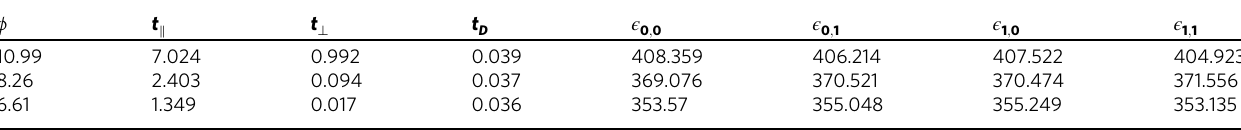
Table 2 Fitted values for the tight binding model of Eq. (3) for three different angles as shown in Fig.